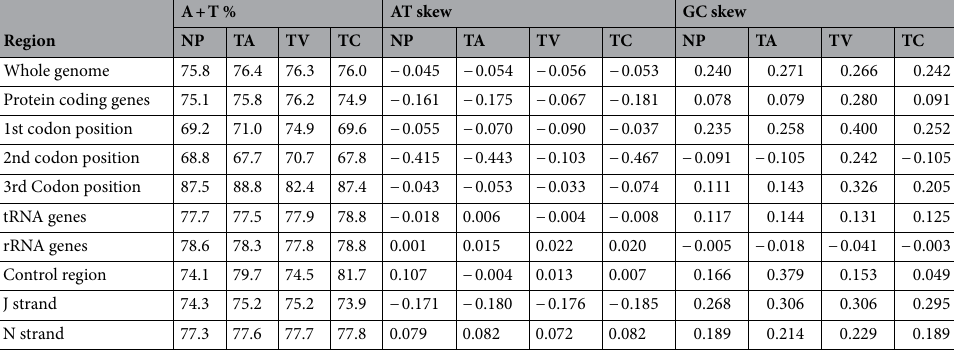
Table 2. A + T content (%), AT and GC skewness of the Nephila and Trichonephila mitogenomes. NP, Nephila pilipes ; TA, Trichonephila antipodiana ; TV, Trichonephila vitiana (previously N. vitiana ); TC, Trichonephila clavata